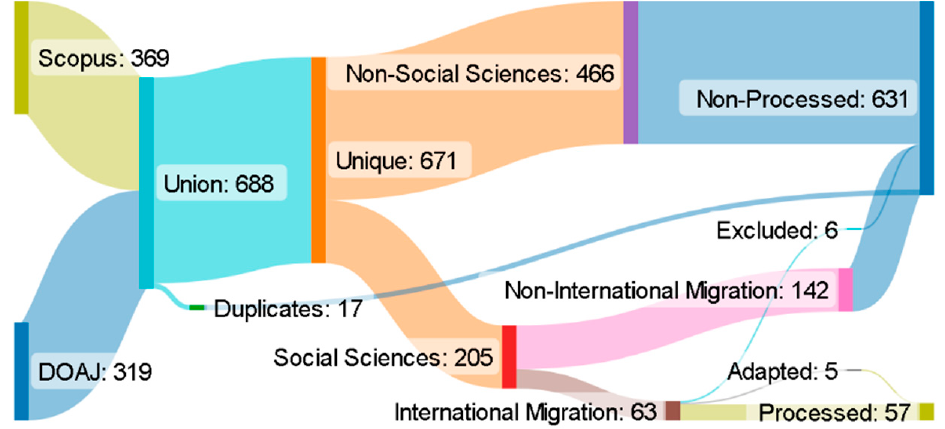
Figure 5. Flow chart of the classification procedure that we followed.